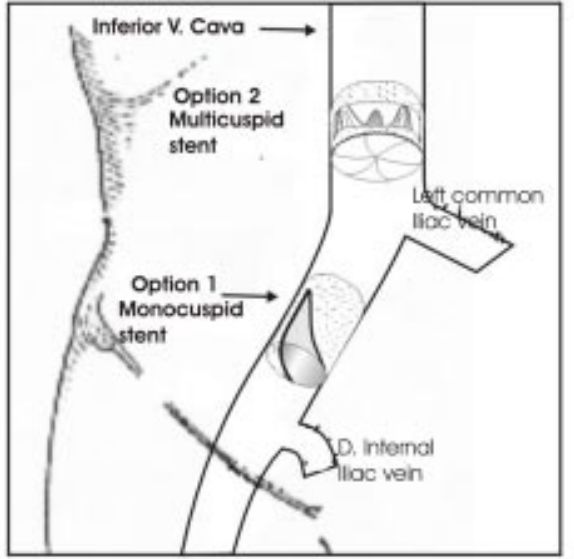
Fig. 2 - Options of valved stent implatation in common iliac or inferior vena cava.